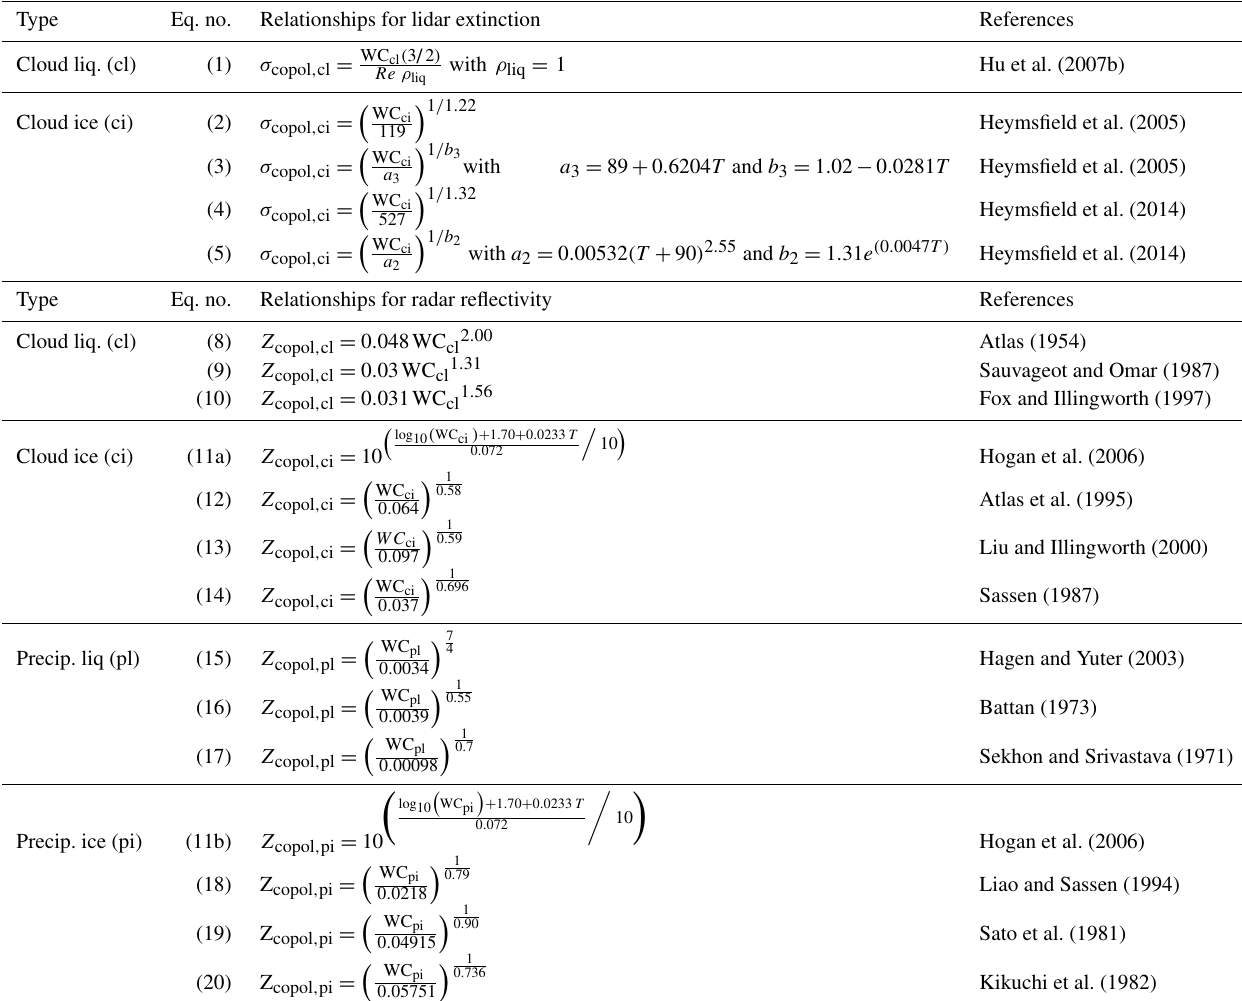
Table 2. Empirical relationships used to convert hydrometeor in-cloud hydrometeor water content (WC; gm − 3 ) to lidar extinction ( σ ; m − 1 ) and radar reflectivity ( Z ; mm 6 m − 3